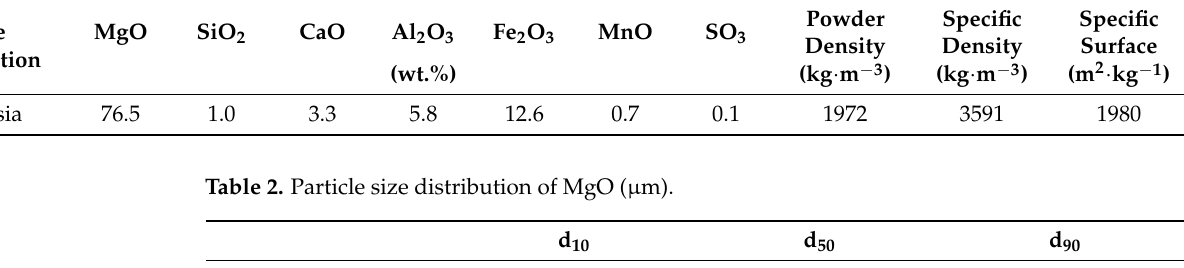
Table 1. Chemical composition and physical properties of MgO.